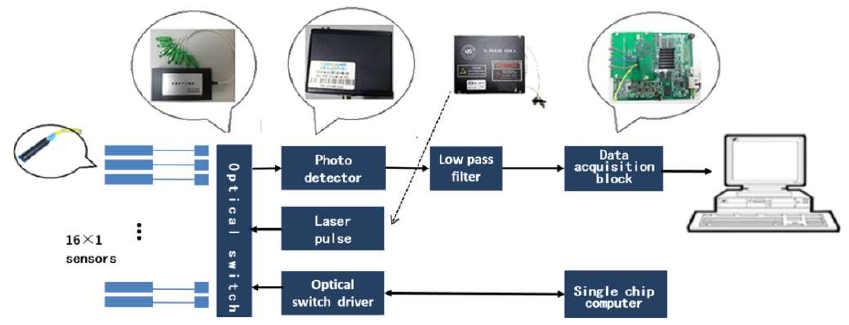
Figure 1. The electromagnetic imaging system.